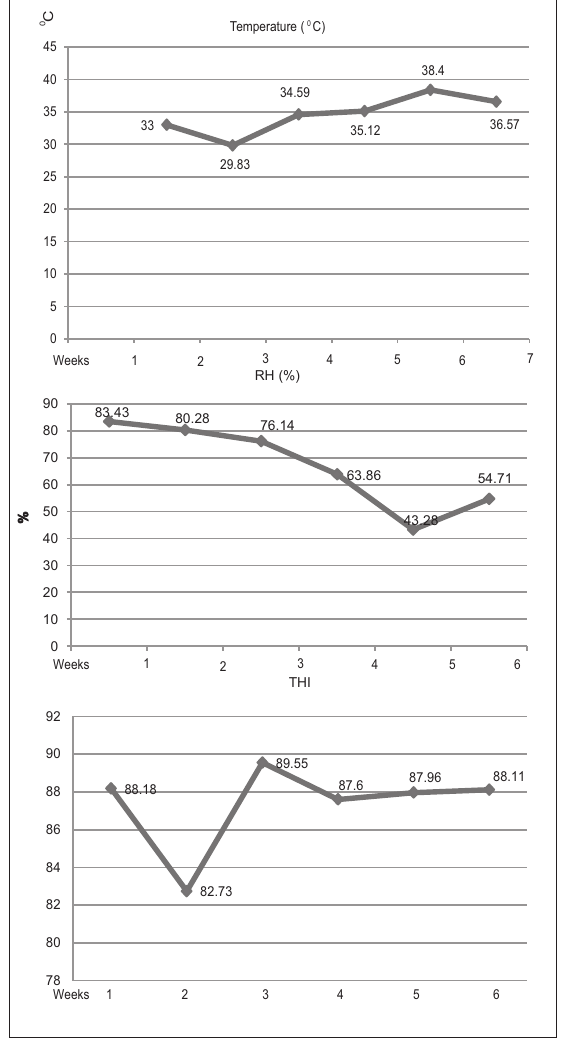
Figure-1: Temperature, relative humidity, and temperature humidity index trend over the weeks.